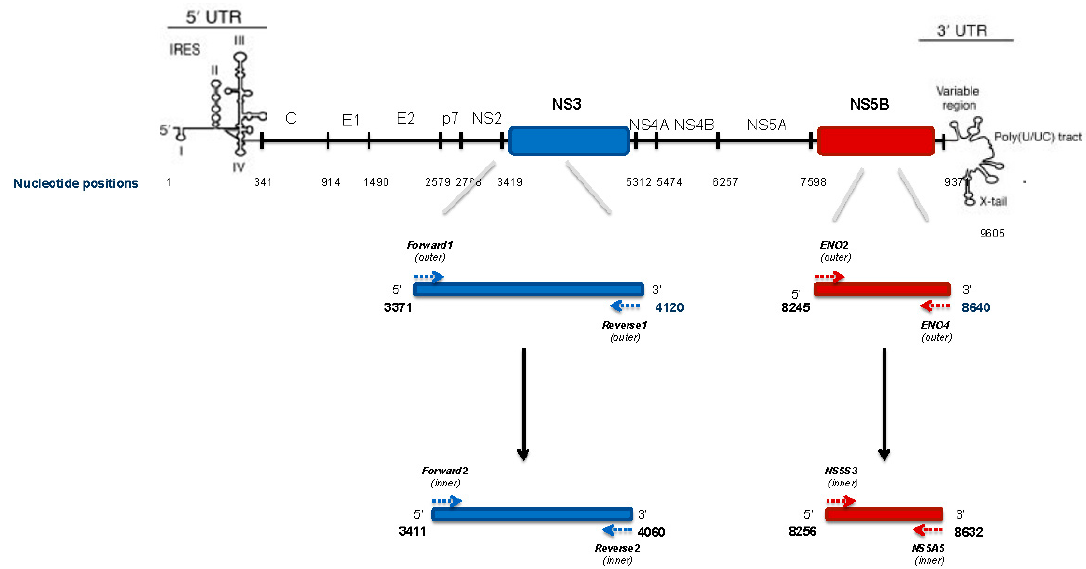
Figure 2. PCR primers positions and amplicons lenght for NS3 and NS5B HCV genomic regions, according to the HCV1b reference sequence (Con1 AJ238799).